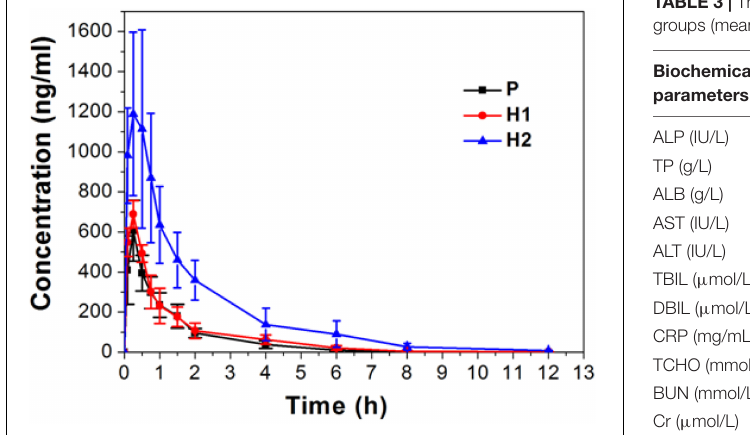
Figure 3 | Plasma concentration-time profiles of sildenafil in rats at low altitude and after acute exposure to high altitude.